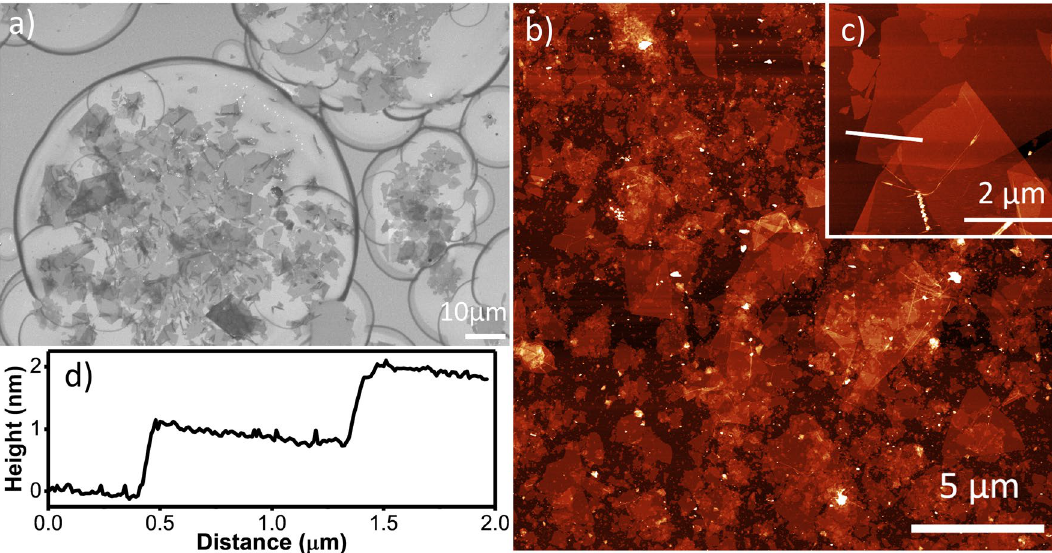
Figure 1. ( a ) SEM image of electrosprayed Ti 0.87 O 2 nanosheets only partly covering the Si substrate before thermal annealing, ( b , c ) AFM image of electrosprayed Ti 0.87 O 2 nanosheet film after thermal annealing, ( d ) line height profile extracted from data in image ( c